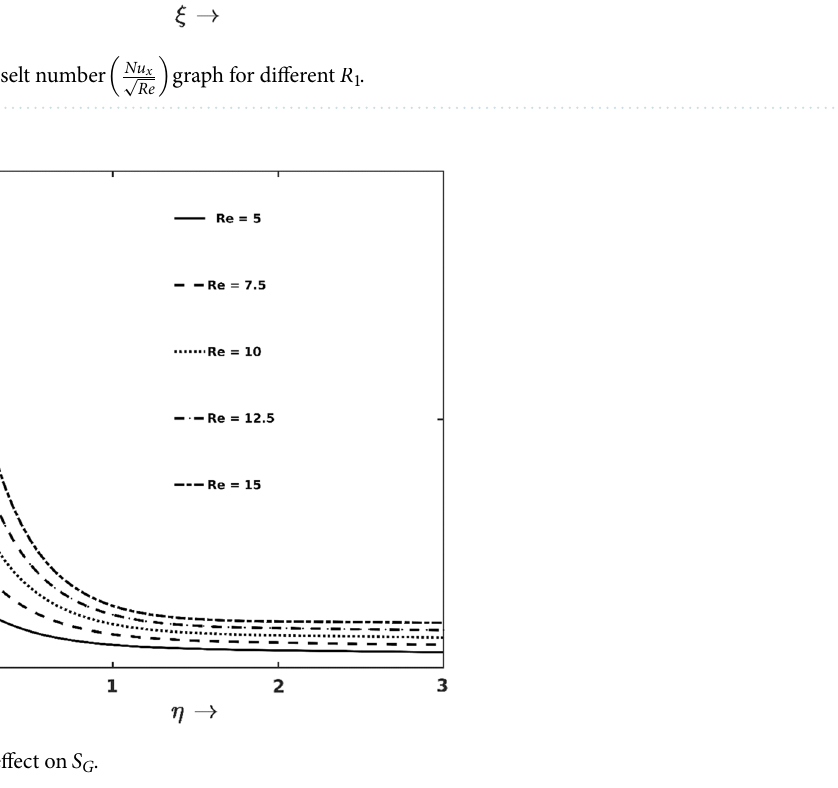
Figure 7. Re effect on S G